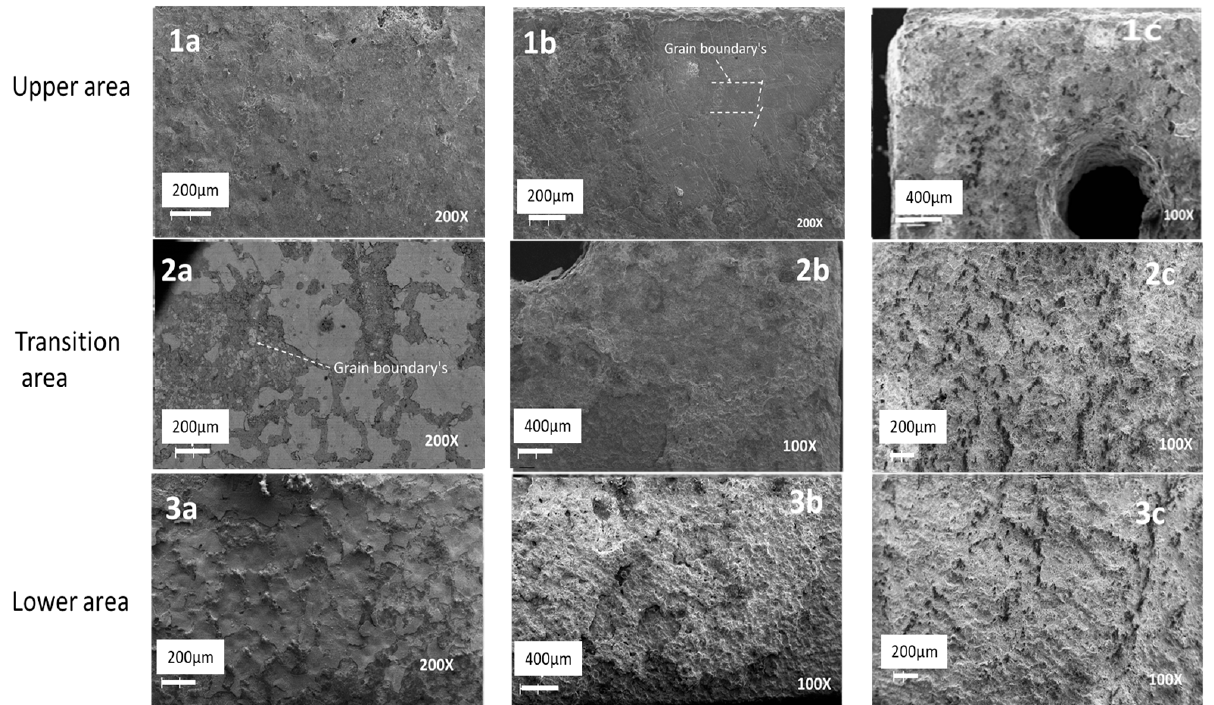
Figure 4. The surfaces of the three areas of SS316L stainless steel ( 1a – 3a ), Incoloy © -800H ( 1b – 3b ) and Hastelloy ® G35 ® ( 1c – 3c ) are shown in the image.